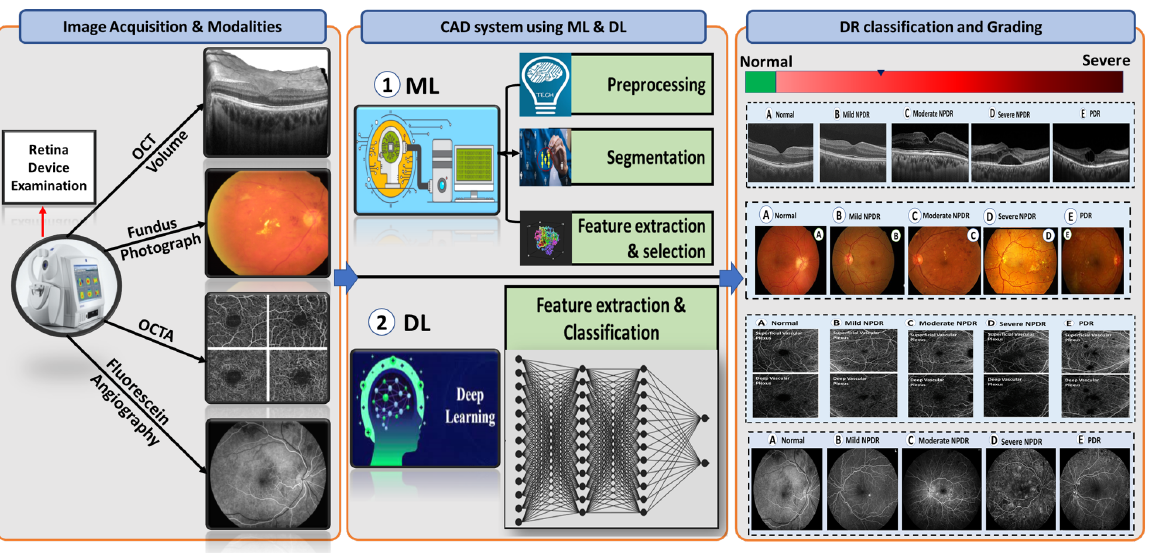
Figure 7. A flow diagram for a generic computer-assisted diagnostic (CAD) for DR